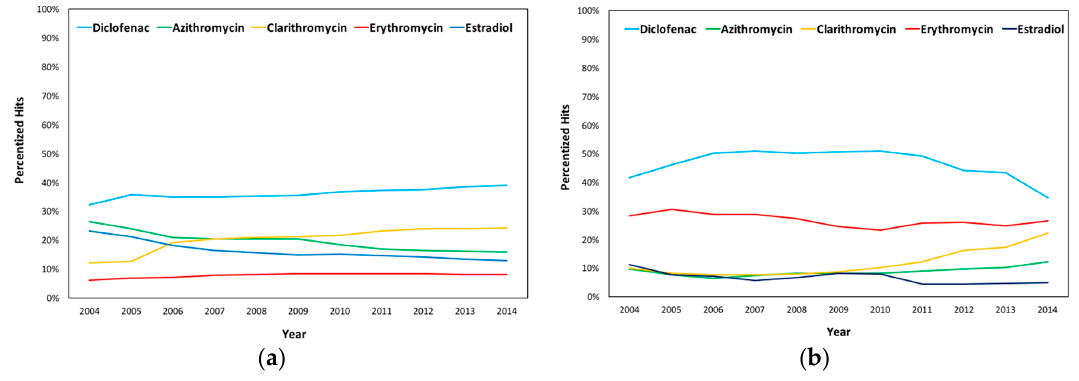
Figure 1. Yearly Averages of the ( a ) Worldwide and ( b ) UK Percentized Hits from 2004 to 2014.